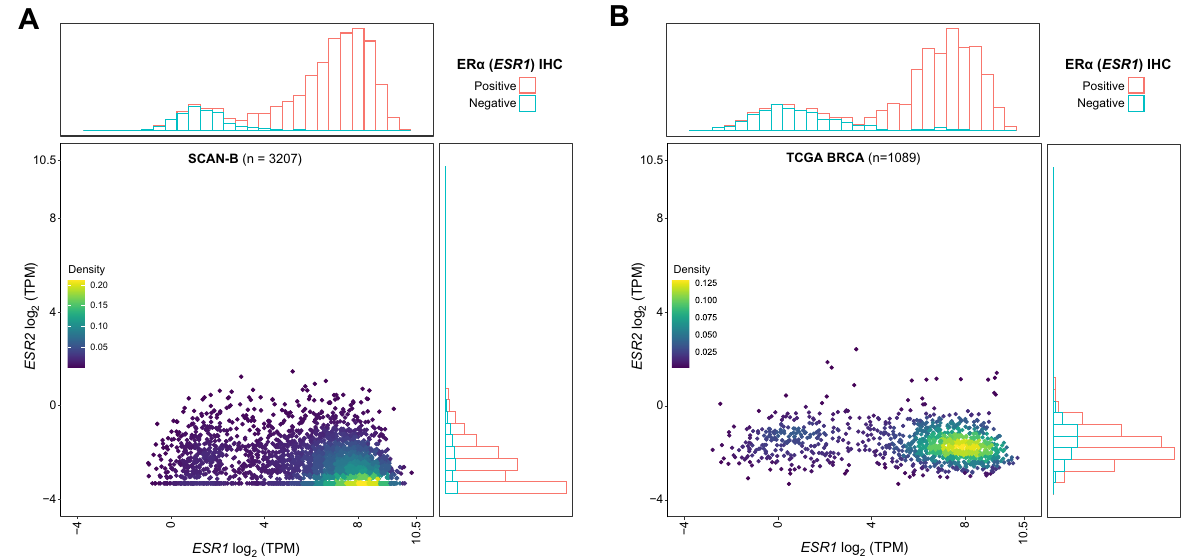
Figure 1 . ESR1 and ESR2 mRNA expression in SCAN-B and TCGA data sets. ( A ) Scatterplot of ESR1 and ESR2 mRNA expression (log 2 TPM). ESR1 and ESR2 data points are colored by density using 2D kernel density estimation function from the MASS R package. Adjacent to the scatterplot, histograms are shown indicating the frequency of expression values and color-coded according to ERα clinical status. ( B ) Expression of ESR1 and ESR2 is shown for the TCGA dataset as in panel